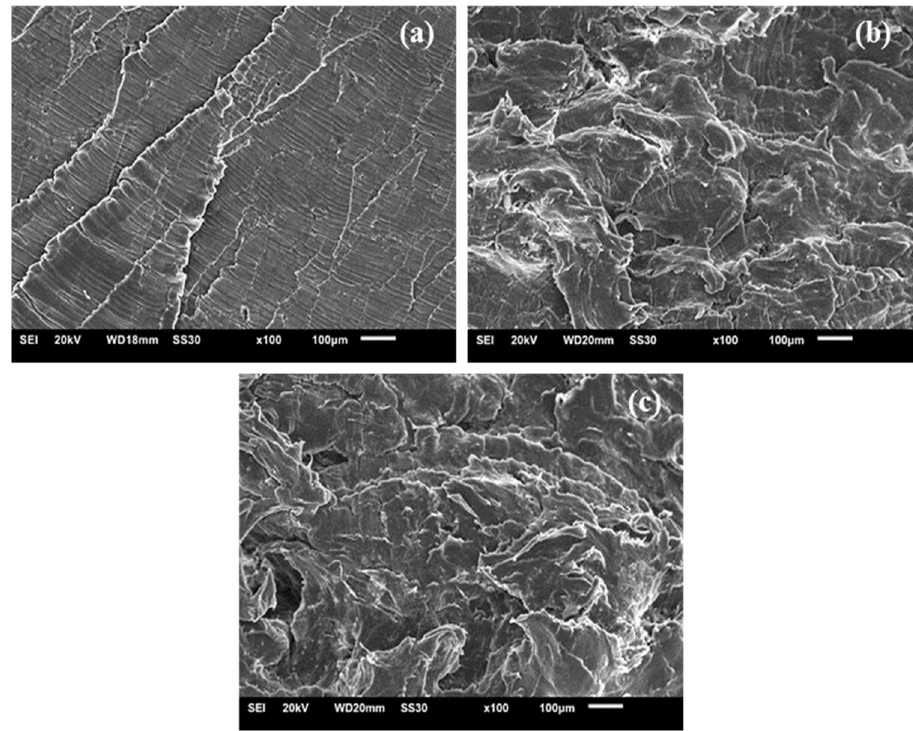
Figure 15. SEM images of UHMWPE with ( a ) 0% peroxide, ( b ) 1% peroxide and ( c ) 2% peroxide.